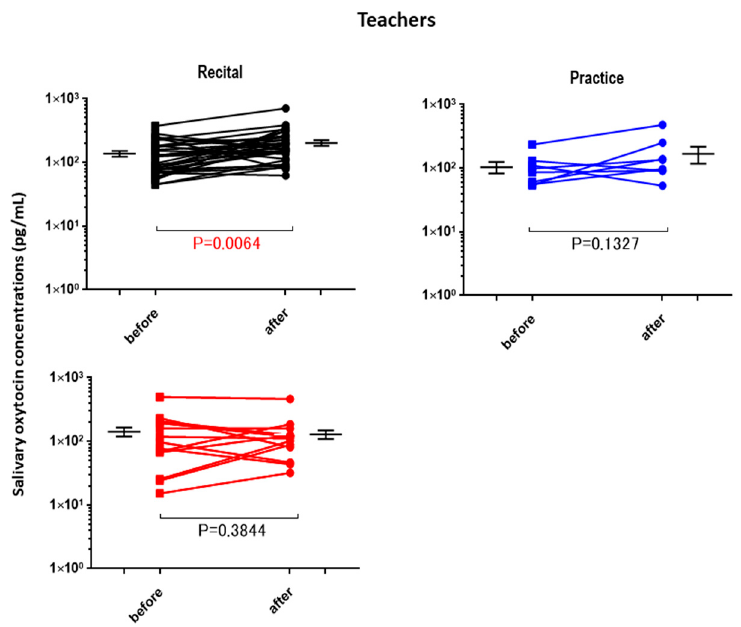
Figure 4. Changes in teachers’ oxytocin levels before and after a single play session. Oxytocin levels are for the first (before) and second (after) salivary samples. Saliva was collected at each recital ( n = 33), practice ( n = 8), and free play ( n = 14) session. p values are for two-tailed Student’s t -tests.